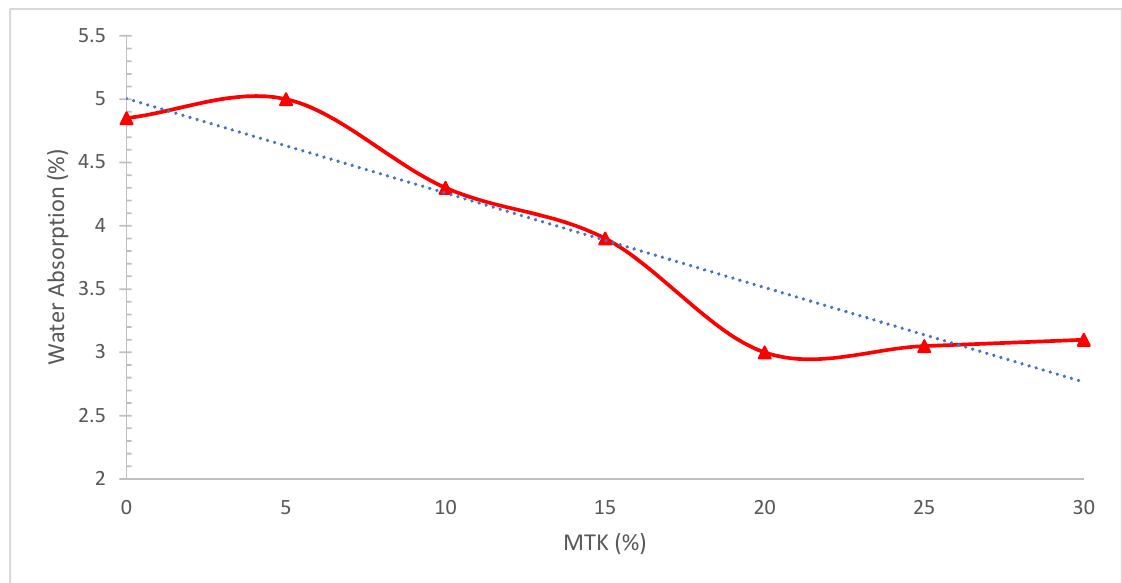
Figure 12. Water absorption [90] .